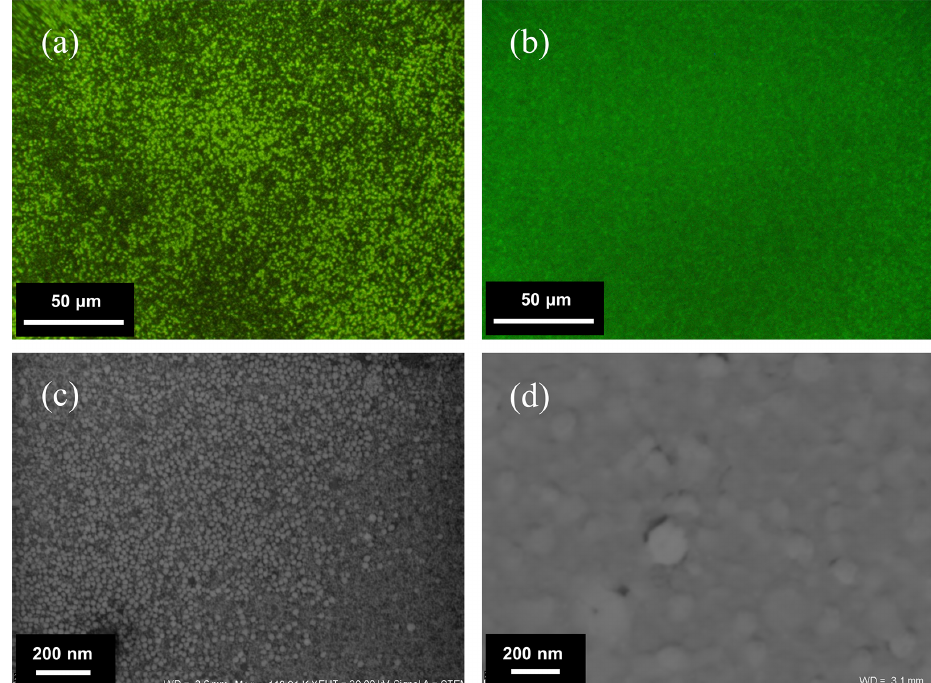
Figure 2. Epifluorescence microscope images of purified bacteriophages stained with SYBR ® Gold – (a) Escherichia phage P1 and (b) Pseu- domonas phage (cid:56) 6 – and SEM images – (c) Escherichia phage P1 stained with uranyl nitrate and (d) Pseudomonas phage (cid:56) 6 without